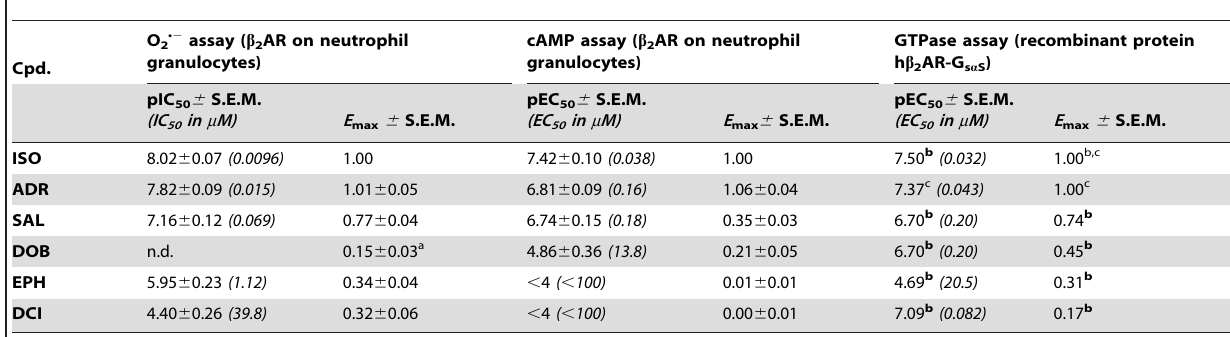
Table 1. Comparison of potencies and efficacies of standard b 2 AR agonists, determined in three different test systems.